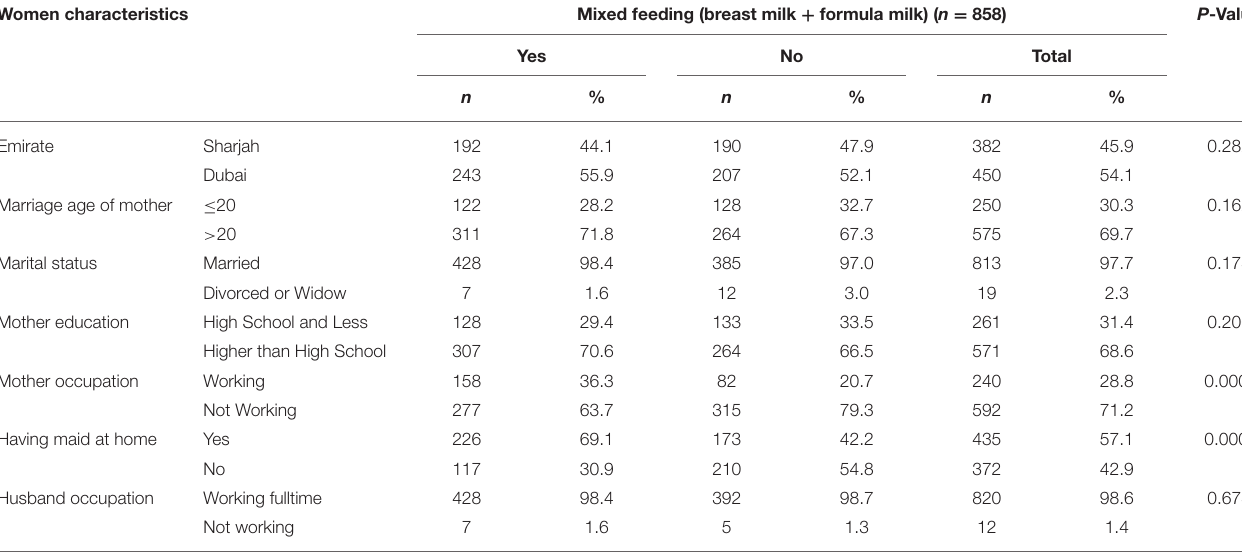
TABLE 3 | Association between mixed feeding (breast milk and formula milk and women’s sociodemographic characteristics. Women